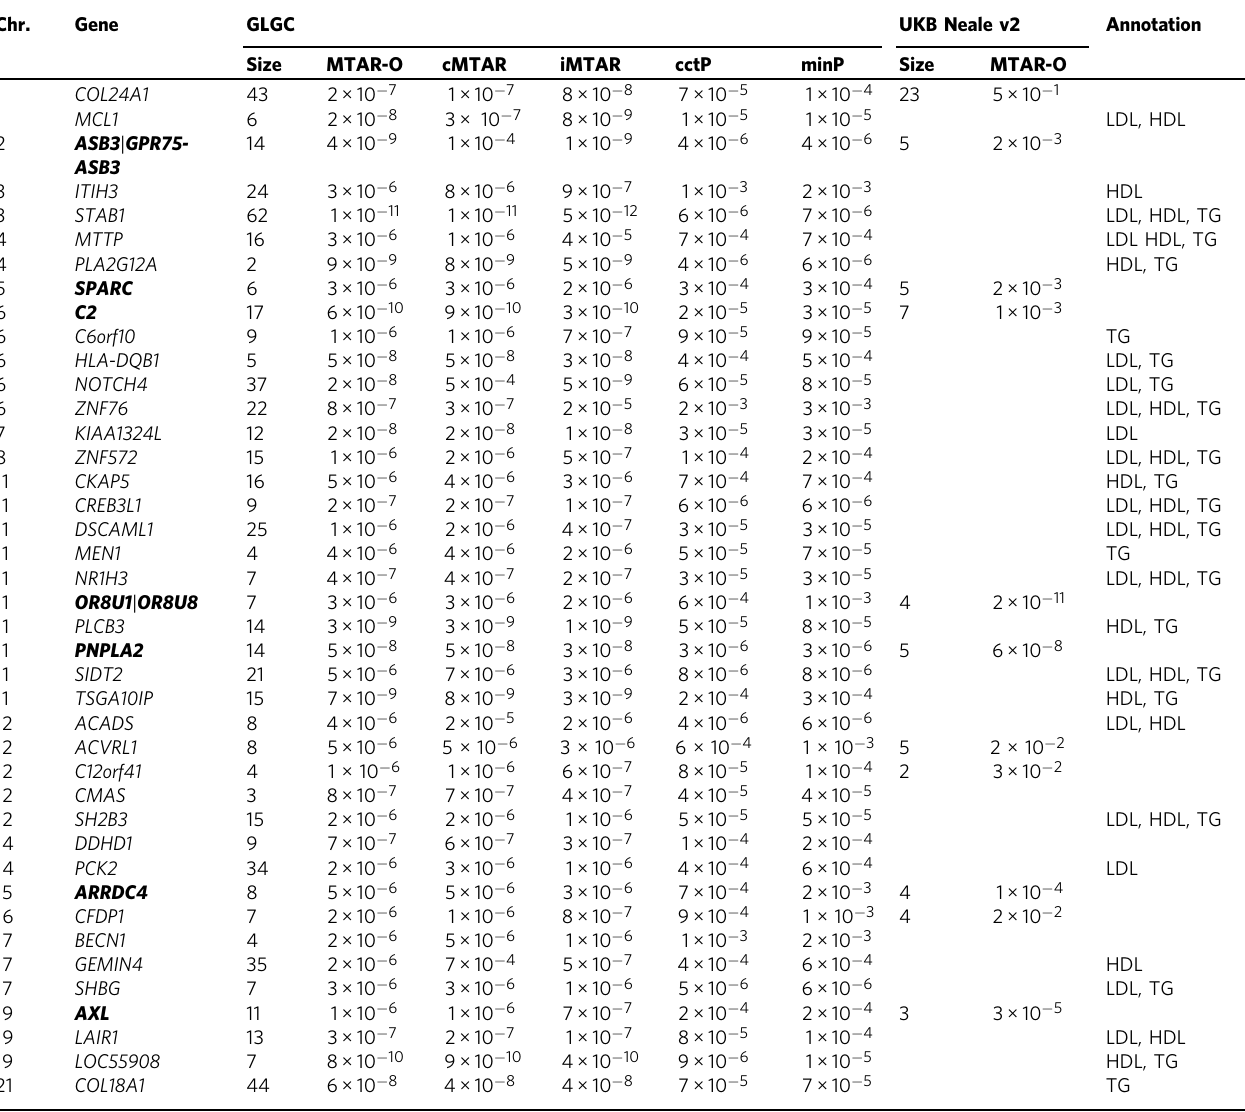
Seven novel genes replicated in the UK Biobank analysis are shown in bold. The annotation is the summary of association evidence from the Open Targets 52,53 and the STOPGAP 54 databases, and the previous analysis of the GLGC data 33 for the three traits. The genes ( BECN1 , CAMS , and DDHD1 ) with cumulative minor allele counts <10 in the UK Biobank are not analyzed in the replication